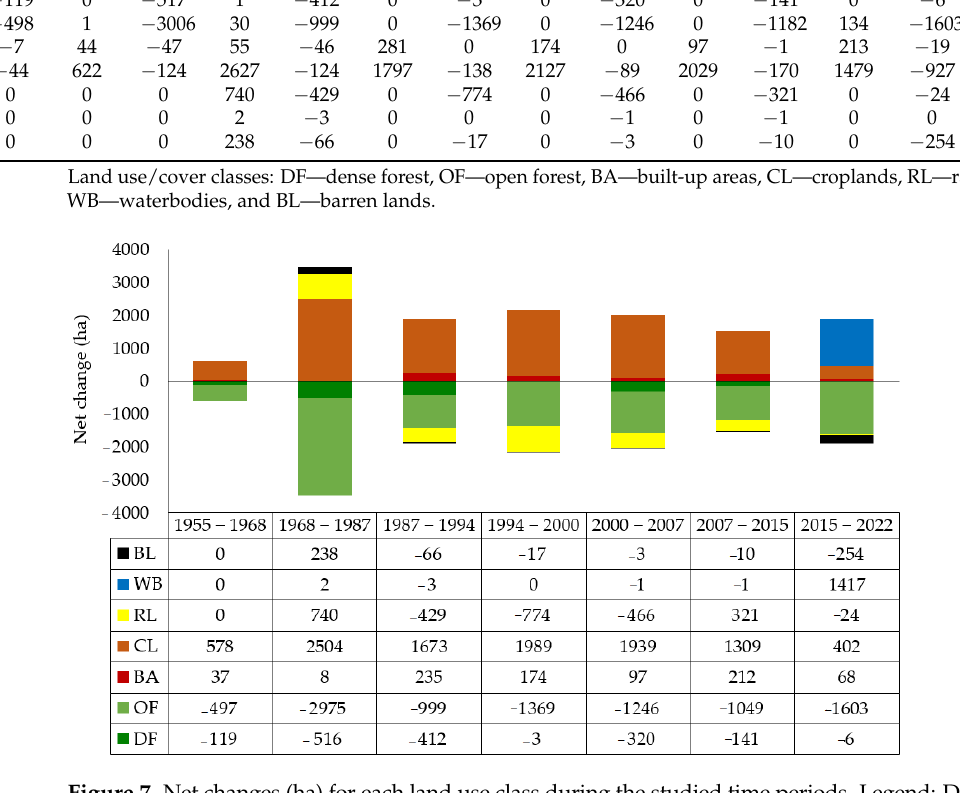
Table 5. Losses ( − ) and gains (+) (ha) in land use classes across the studied time periods. Time Periods Land Use/Cover Class